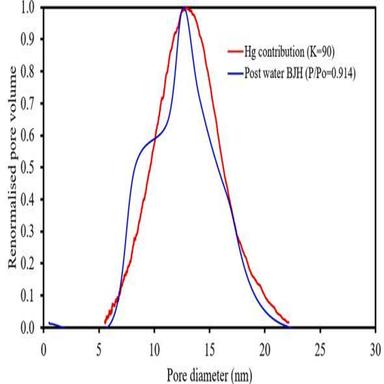
Comparison of the BJH PSD obtained from the nitrogen adsorption isotherm measured after water adsorption to P/P0 = 0.914, shown in, and the PSD from DSC thermoporometry for mercury entrapped in G1 shown in.